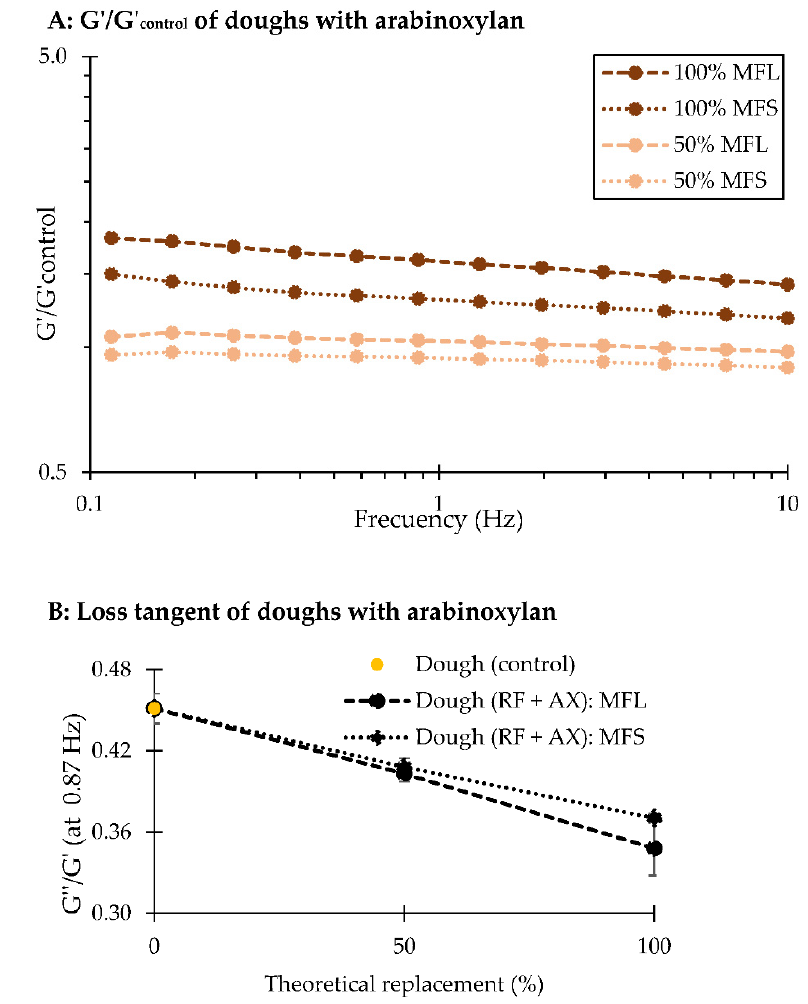
Figure 3. Frequency sweep curves represented by G’/G’control (where the control corresponds to the dough prepared with refined flour) as a function of frequency (Hz) of model flours enriched with arabinoxylans with an equivalent content to that found in flours with 50 or 100% whole flour replacement (MFL: coarse bran; MFS: fine bran) (A). The loss tangent curves (G’’/G’) as a function of replacement at a frequency of 0.87 Hz are also shown (B).